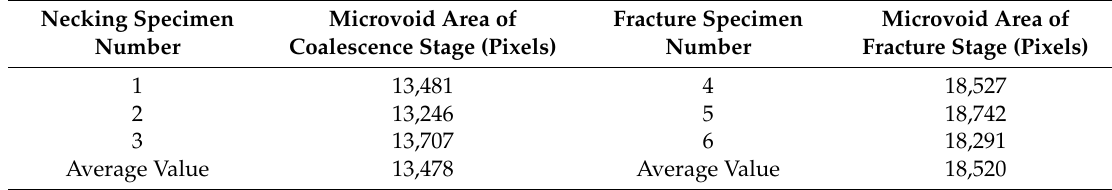
Table 3. The microvoid area of the necking and fracture